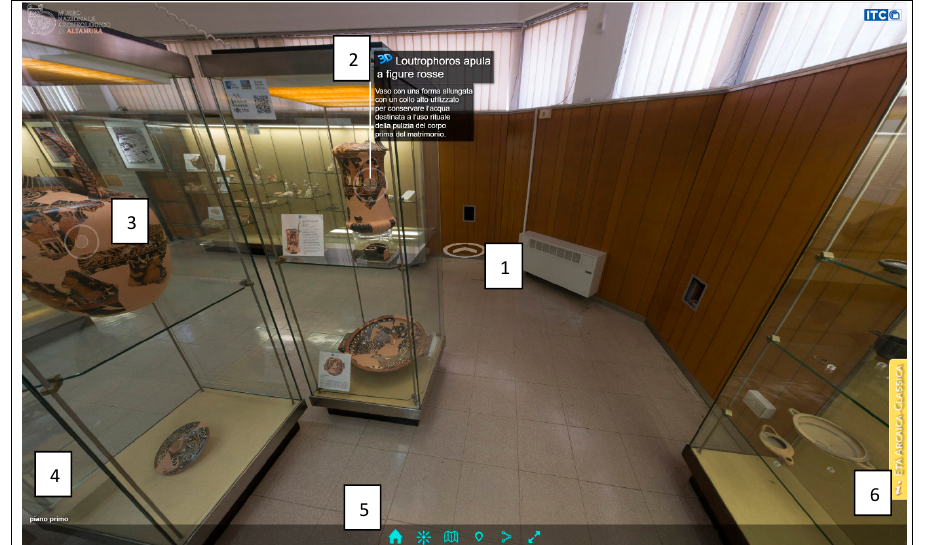
Figure 13. Virtual tour of the National Archaeological Altamura Museum [2] on desktop: (1) scene with navigational arrows; (2) artifact hotspot; (3) hotspot not yet opened; (4) floor level; (5) command bar (6) tab to open the Museum Section information window.